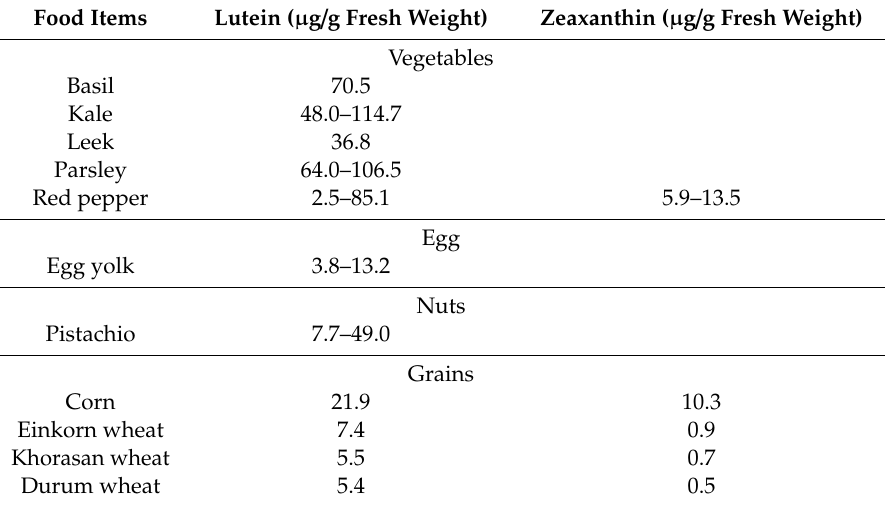
Table 1. Common dietary sources of xanthophylls